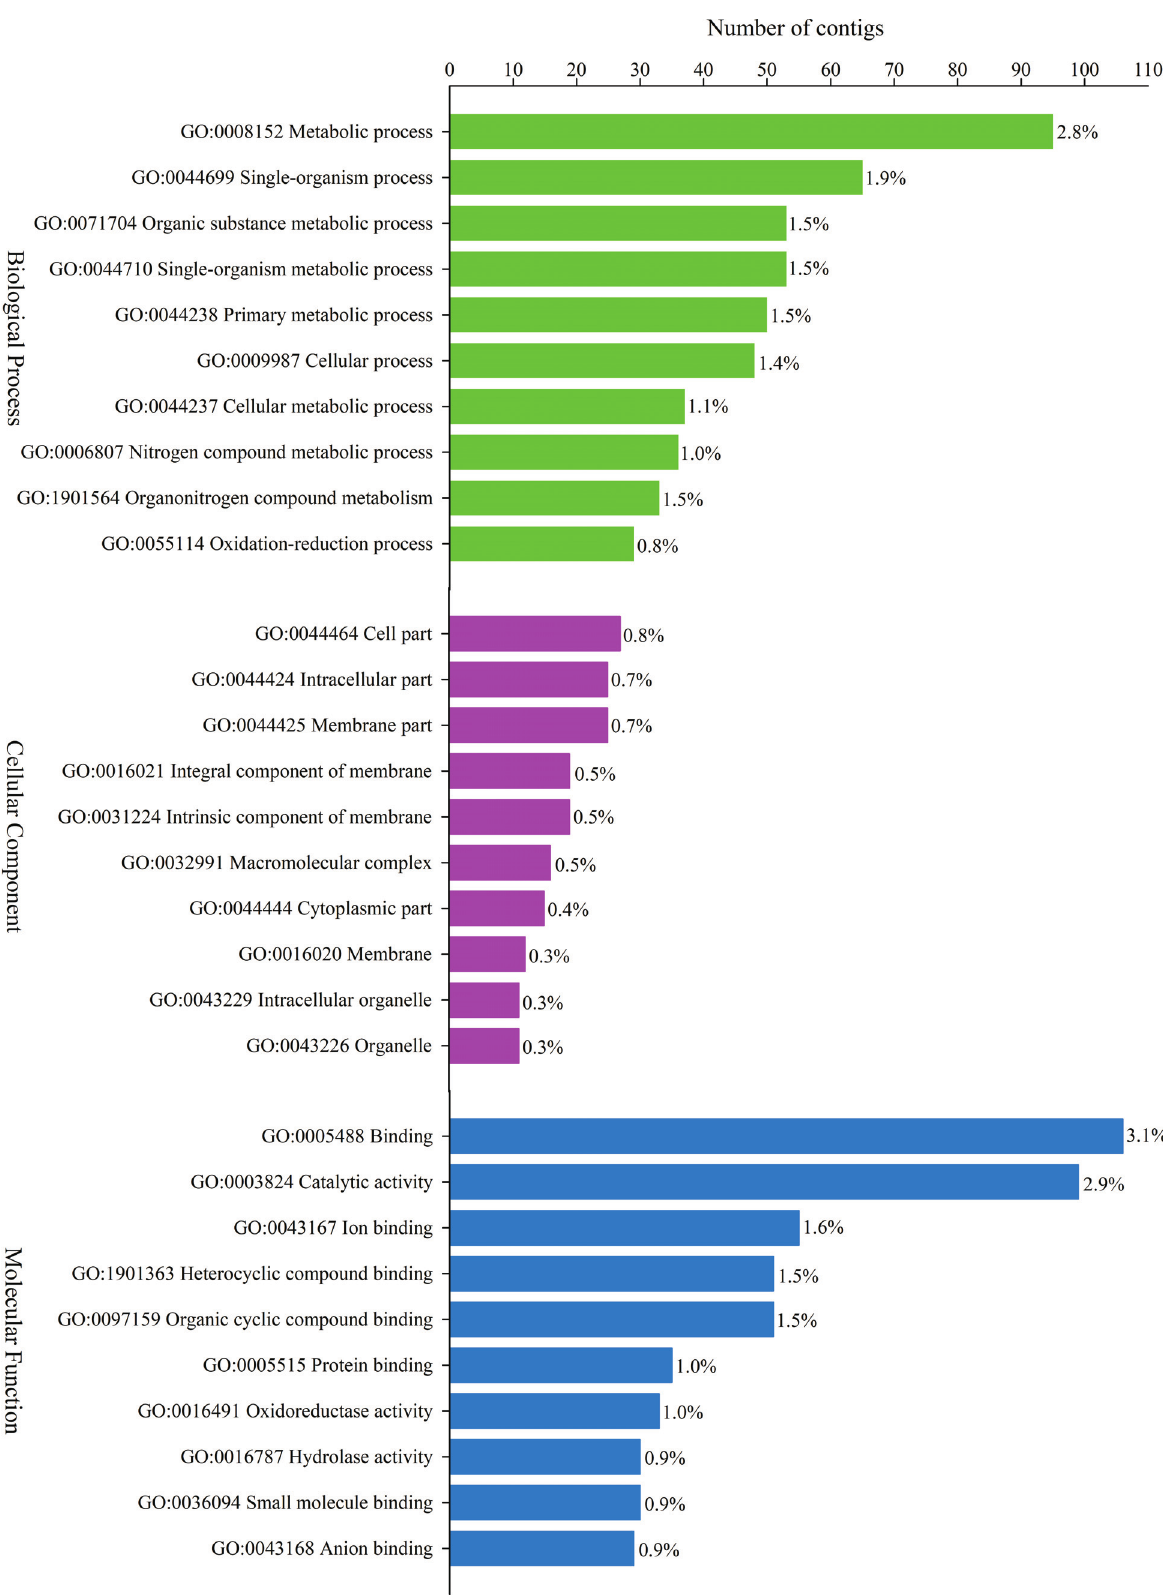
Figure 2 - The top 30 terms classification of the contigs significantly upregulated in Balbina population and separated into three functional Gene Ontol- ogy (GO) categories: Biological Process (green bars), Cell Component (purple bars) and Molecular Function (blue bars). The percentages indicate the representation of genes that belong to each